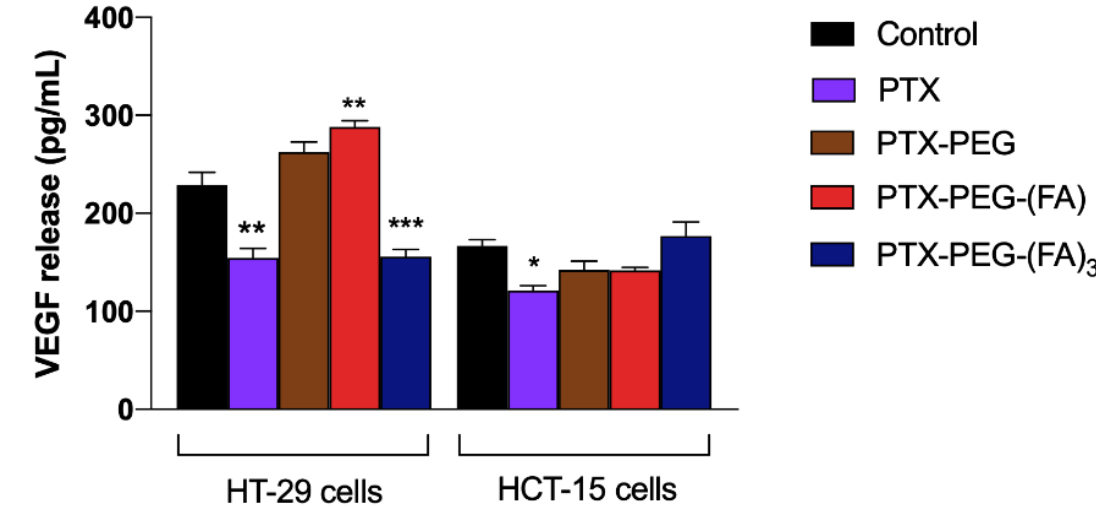
Figure 7. VEGF release from HT-29 and HCT-15 cells exposed to PTX and PTX-PEG-FA conjugates. * p < 0.05, ** p < 0.01, *** p < 0.001 vs. control untreated cells. The results are the mean of three independent experiments, each performed in